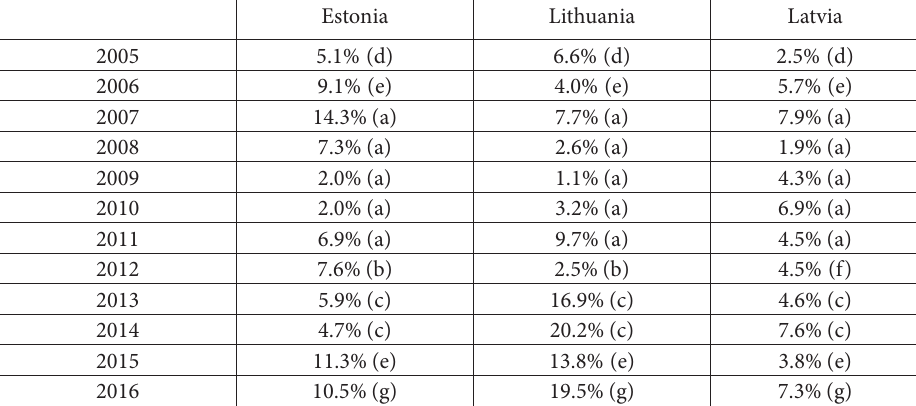
Table 1. Market share of national films production including co-production (Cinema D’Europa MEDIA Salles 2014 (a); UNIC 2015 (b), 2016 (c); Baltic Films: Estonia, Latvia, Lithuania 2006 (d), 2007